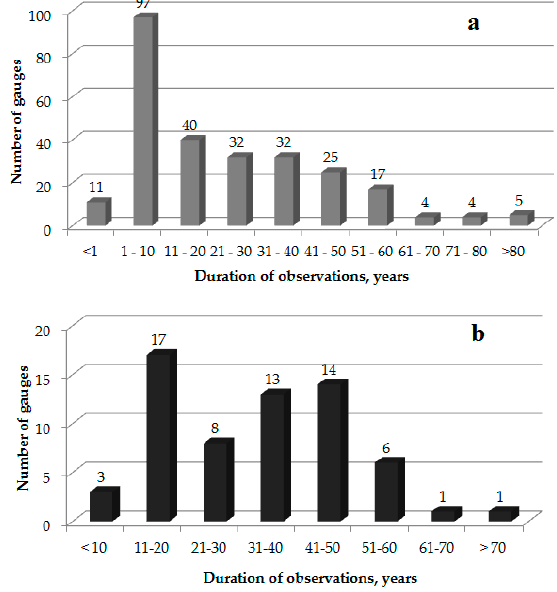
Figure 3. Duration of observations on monitoring stations measuring water discharge ( a ) and suspended sediment yield ( b ) in the Kamchatsky Krai.